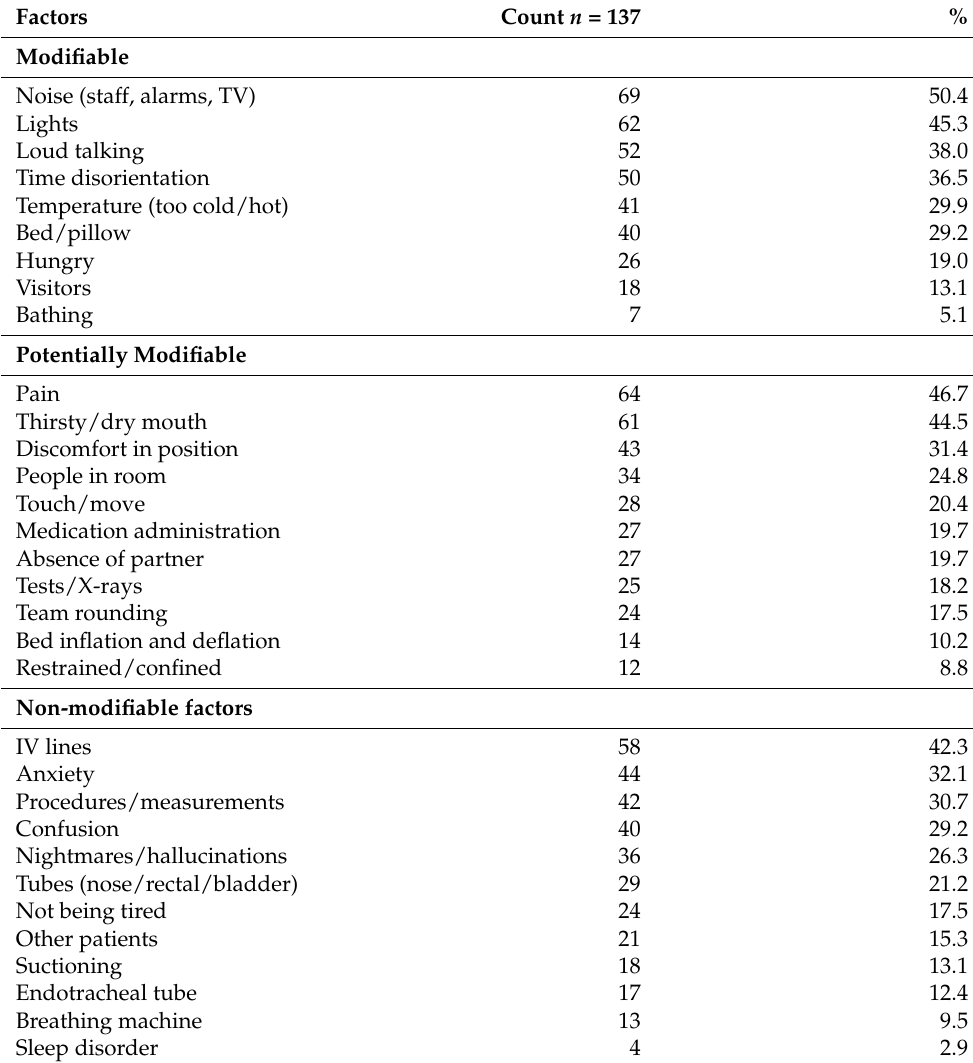
Table 1. Self ‐ reported factors that led to poor sleep in the ICU.